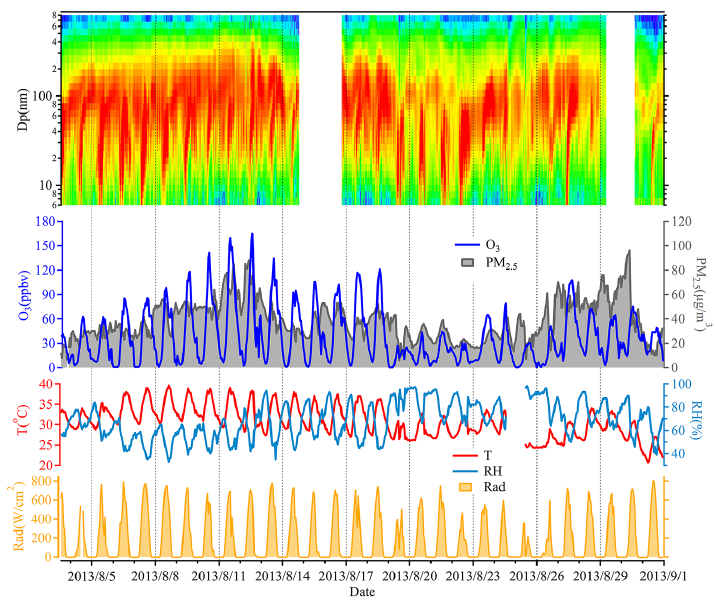
Figure 12. Time series of (a) particle number size distribution, (b) O 3 and PM 2 . 5 concentrations, (c) temperature and RH, and (d) intensity of radiation measured at the SORPES site in August 2013.